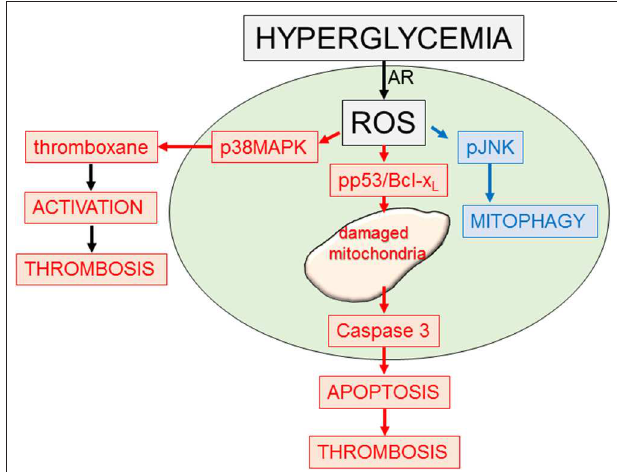
FIGURE 3 | Platelet response to hyperglycemia. Diagram outlining some of the signaling and functional responses to stress (hyperglycemia). Increased glucose (hyperglycemia) through the aldose reductase enzymic system can lead to enhanced reactive oxygen species (ROS). This can activate multiple pathways including p38MAPK, promoting platelet activation and thrombosis ( 93); phosphor-p53 and Bcl-xl, promoting mitochondrial damage, apoptosis, and thrombosis ( 94); and a mitophagy rescue response, removing toxic damaged mitochondria (